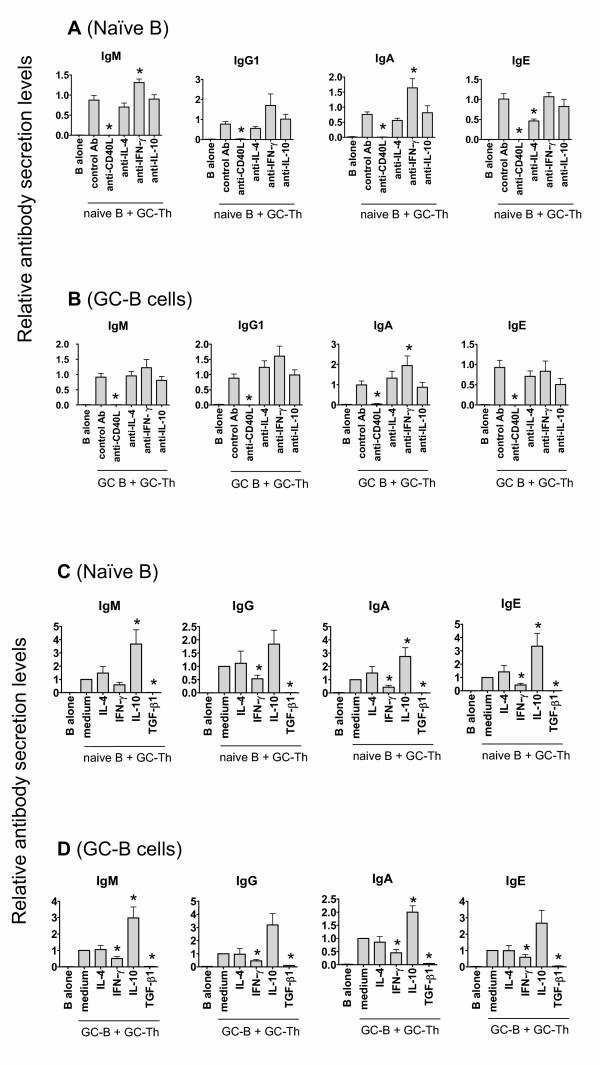
CD40L and cytokines in regulation of the helper activity of CD57+ GC-Th cells. (A and B) Effects of endogenous CD40L and cytokines on the helper activity of CD57+ GC-Th cells were determined. In cultures of CD57+ GC-Th cells with naïve or GC-B cells, neutralizing antibodies to IL-4, IL-10, IFN-γ or CD40L or control antibodies (mouse IgG1) were added. *Significant differences from the control group (control antibody). (C and D) Effects of exogenously added cytokines on the helper activity of CD57+ GC-Th cells were determined. To cultures of CD57+ GC-Th cells with naïve or GC-B cells, IL-4, IL-10, IFN-γ and TGF-β1 were added separately. Cells were cultured for 7 days followed by ELISA for IgM, IgG, IgA and IgE. Relative Ig secretion levels (the medium control = 1) obtained from 9 independent experiments were combined, and averages and standard errors are shown. *Significant differences from the control group (medium).